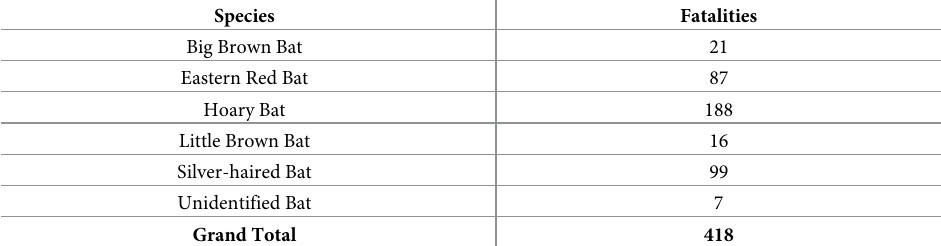
Table 4. Species of bat mortality at wind turbines in the Northeastern